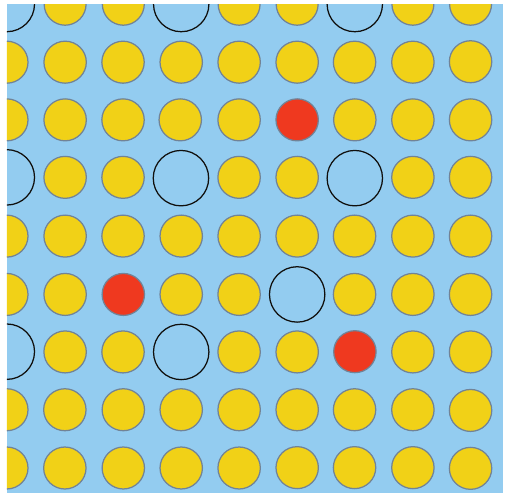
Figure 4: The Th-MOX fuel assembly design (a quarter of the fuel assembly). Yellow rods contain 13.7%, red rods 11.7%, and grey rods 9.0% Pu (weight percent of heavy metal content). The zirconium boride layer is too thin to be visible in the